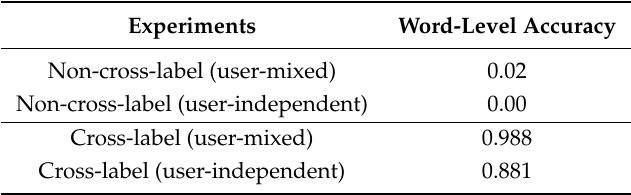
Table 2. Experimental results for the word-6DMG